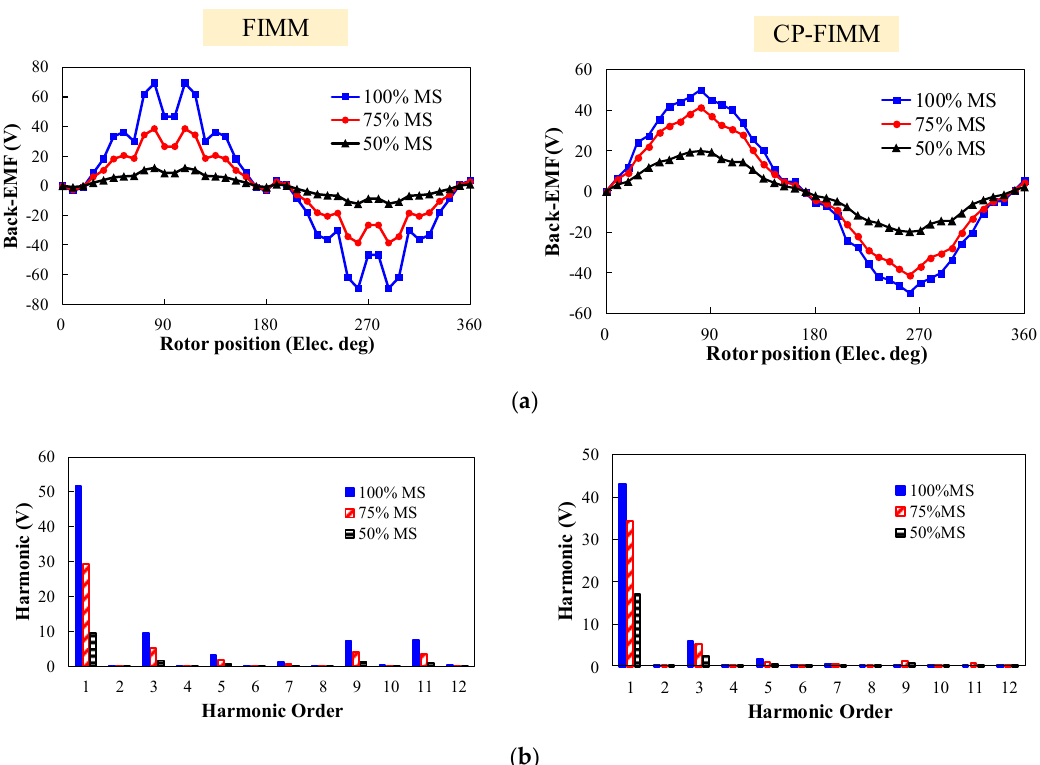
Figure 8. Air-gap flux density of the two machines under different MSs. ( a ) Waveforms, ( b ) spectra.